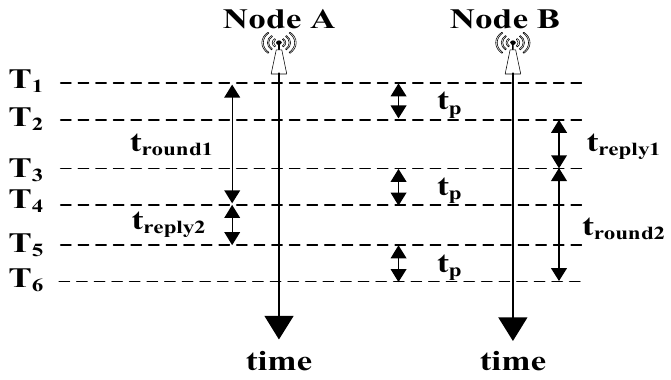
Figure 3. Scheme of double-sided, two-way ranging (DS-TWR).